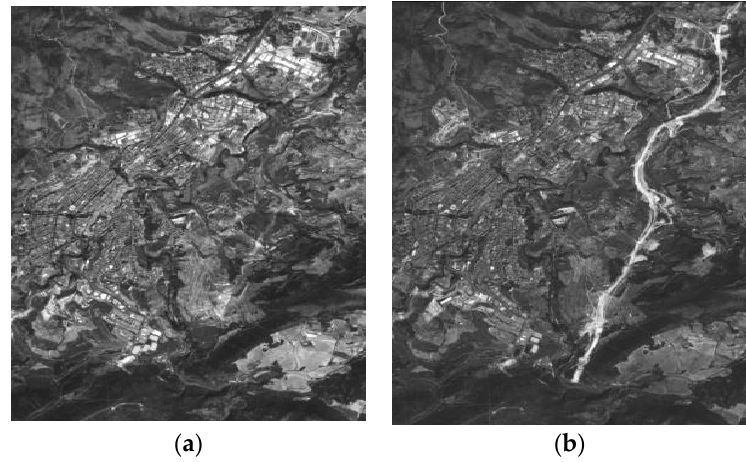
Figure 3. SPOT5-PAN (© SPOT image) multitemporal DS2: ( a ) Acquisition date 14 August 2005; ( b ) Acquisition date 10 August 2008. ( b ) Acquisition date 10 August